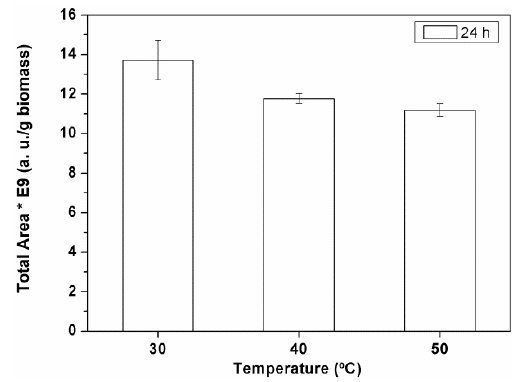
Figure 2. Effect of the temperature on the Alcalase ® assisted extraction of the polar spirulina biocomponents. Variation of total peak areas in the HPLC-ELSD analyses relative to 1 g biomass. Conditions: 1% ( v / w ) enzyme loading and pH 6.5; A.U.: arbitrary units.